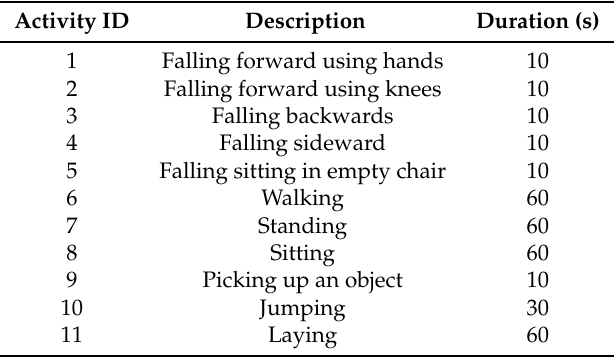
Table 5. Activities performed by